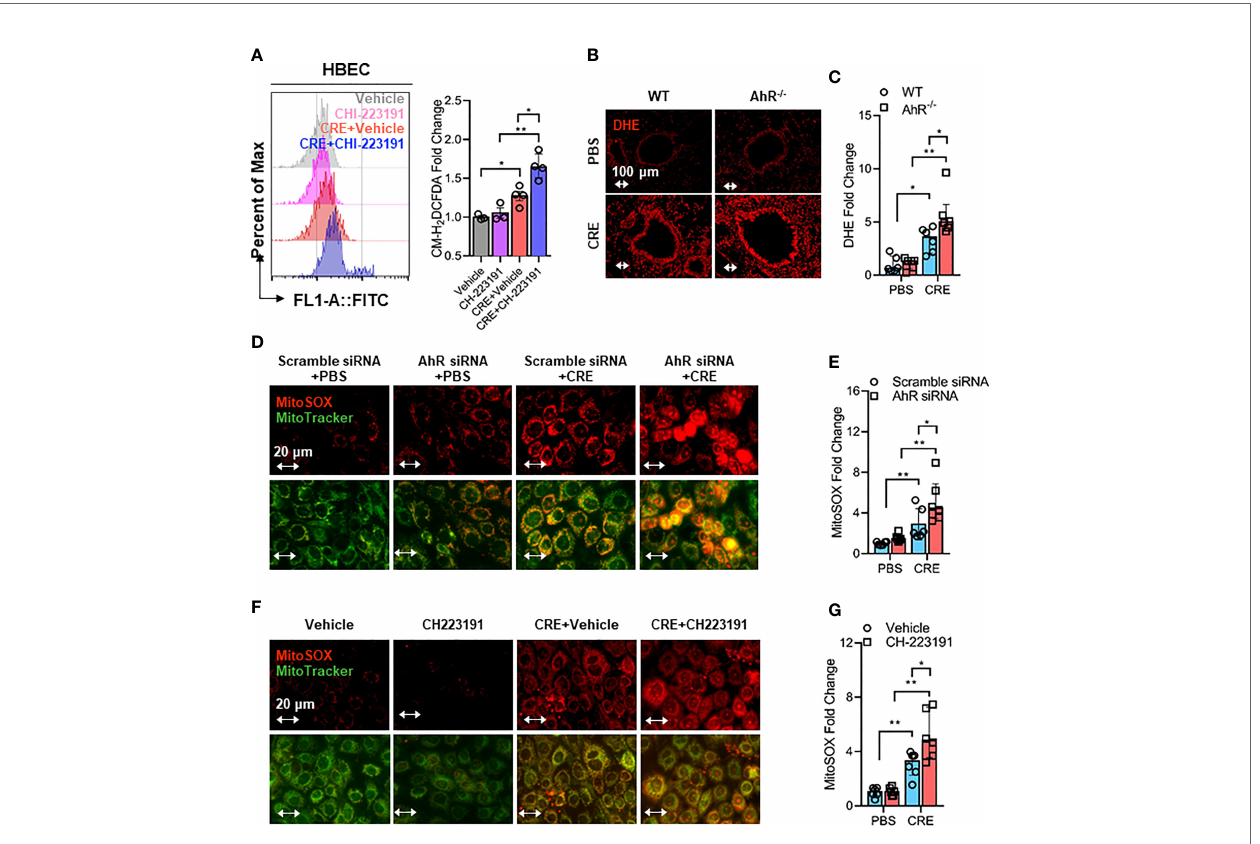
FIGURE 5 | Epithelial AhR prevents cockroach allergen-induced airway epithelial mitochondrial ROS generation. (A) Intracellular ROS production in HBECs were detected by fl ow cytometry analysis with CM-H2DCFDA (n = 4). (B) Representative immuno fl uorescence images of ROS expression with dihydroethidium (DHE) in the lung tissues of cockroach allergen-induced mouse model with wild-type (WT) and AhR -/- mice. (C) Quantitative analysis of fl orescent signals [ (B) , n = 6]. (D) Representative immuno fl uorescence images of mitochondrial ROS expression with MitoSOX in cockroach extract (CRE, 50 µg/ml)-treated HBECs with or without AhR knockdown. (E) Quantitative analysis of fl orescent signals [ (D) , n = 6]. (F) Representative immuno fl uorescence images of mitochondrial ROS expression with MitoSOX in cockroach extract (CRE, 50 µg/ml)-treated HBECs with or without CH223191 (10 µM). (G) Quantitative analysis of fl orescent signals [ (F) , n = 6]. Data represent as medians with interquartile (IQR). * P < 0.05, ** P <